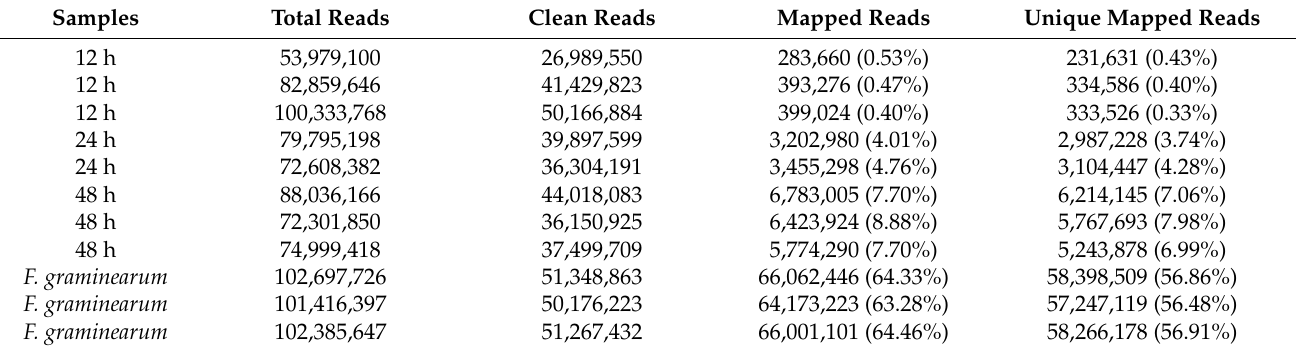
Table 1. Statically analysis of RNA-seq